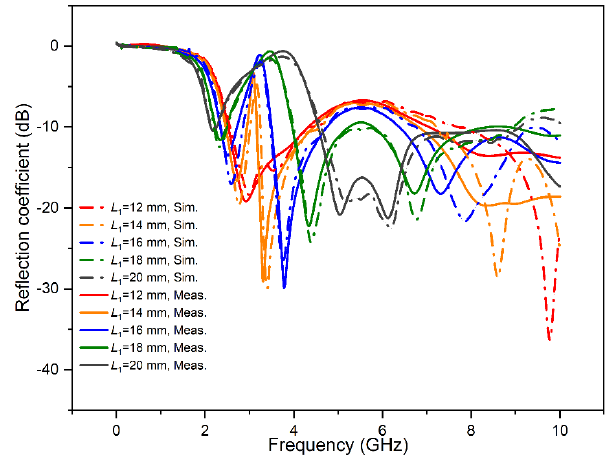
Figure 7. The reflection coefficient of the antenna (the initial condition: L 1 = L 2 = 12 mm).